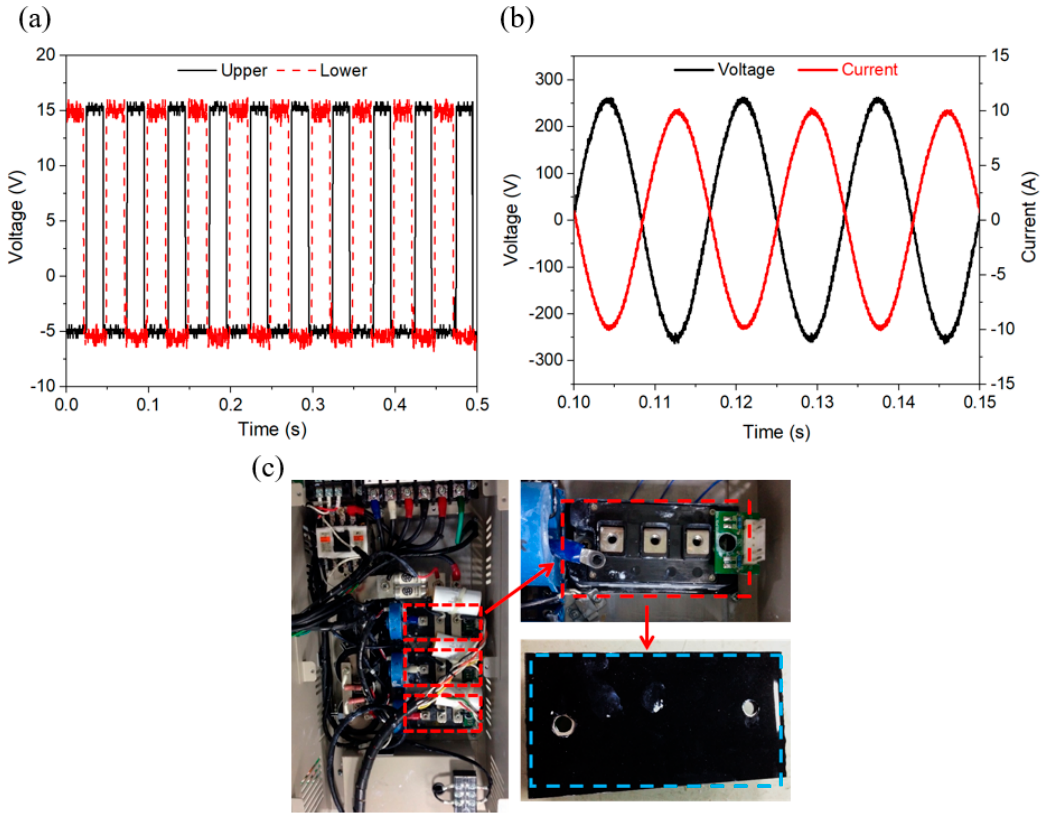
Figure 8. Inverter experiment operating at a frequency of 20 kHz pulse frequency. ( a ) V GE voltage flow over an IGBT inverter for upper and lower arms; ( b ) measurement result of AC waveforms V AC , I AC ; ( c ) TIMs (red dotted square) in measurements on the IGBT heat sources. Red rectangles show the 3 IGBTs in the normal operation position.